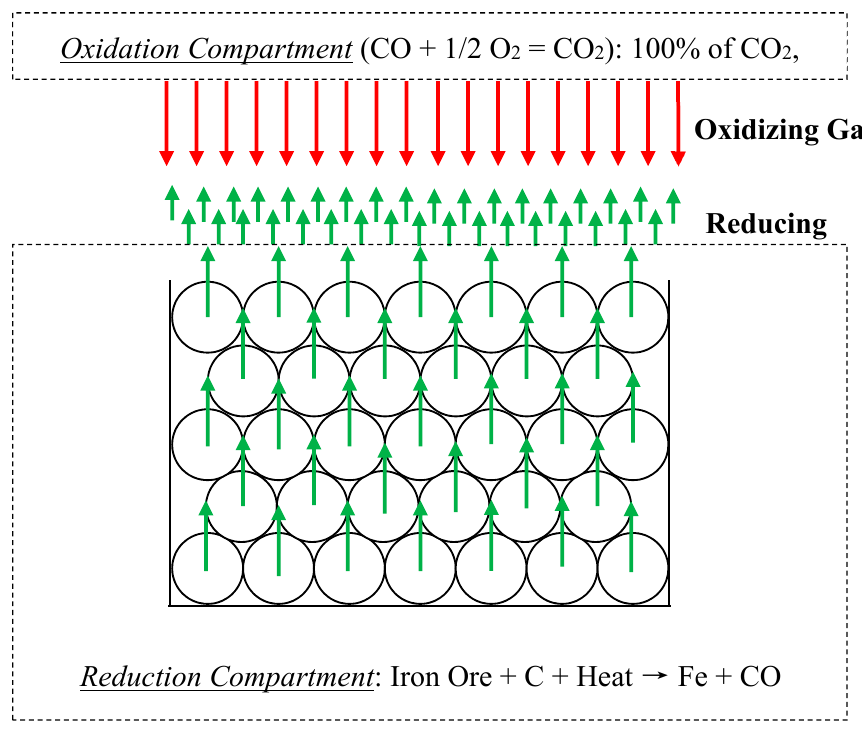
Figure 2. Schematic diagram of the carbothermic reduction in the tall pellets bed.